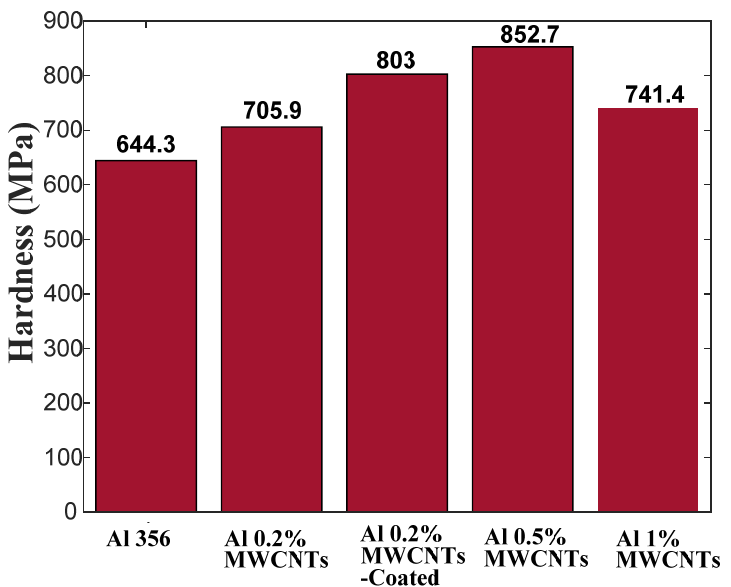
Figure 5. Brinell hardness of base alloy and nanocomposites made with different MWCNTs percentages.